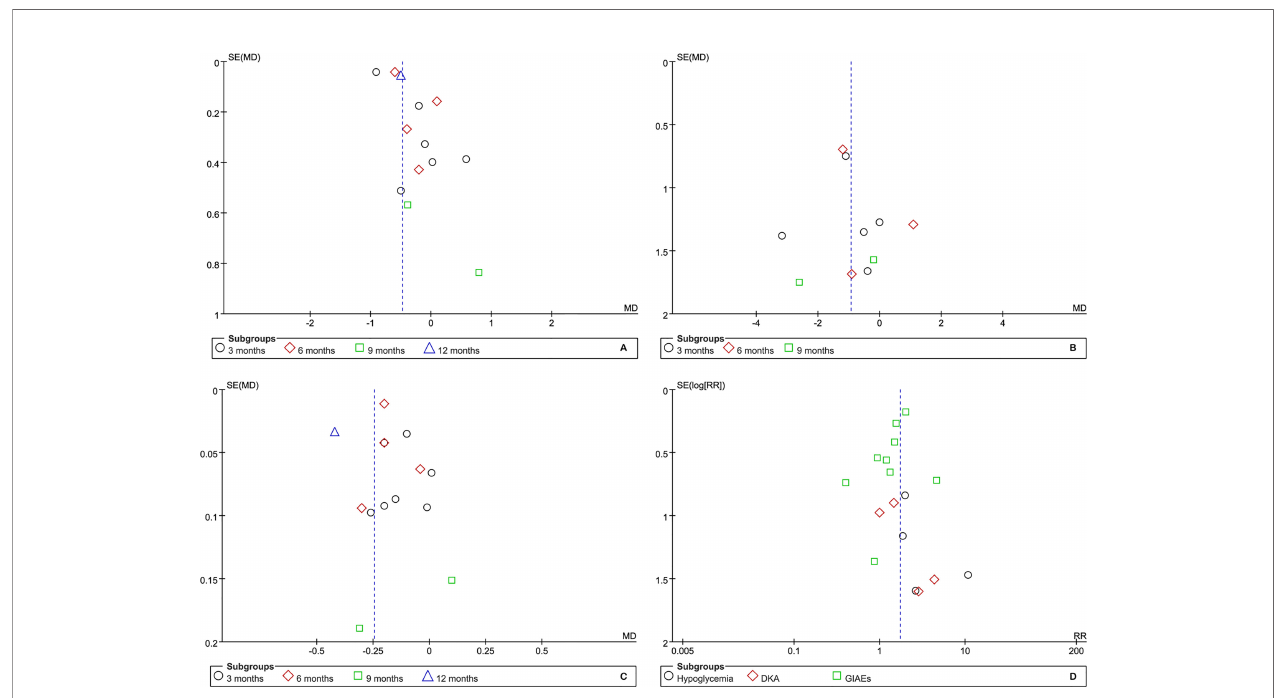
FIGURE 7 | Funnel plot of publication bias for the comparative ef fi cacy and